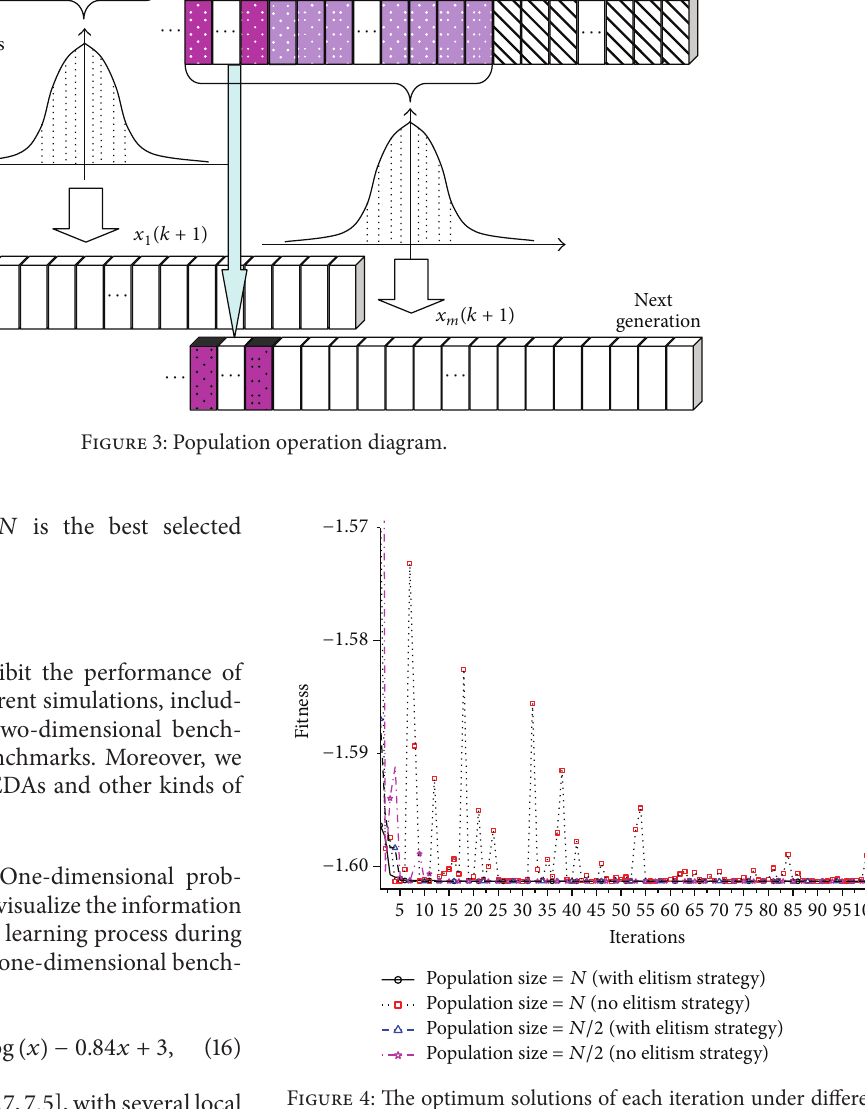
Figure 4: The optimum solutions of each iteration under different